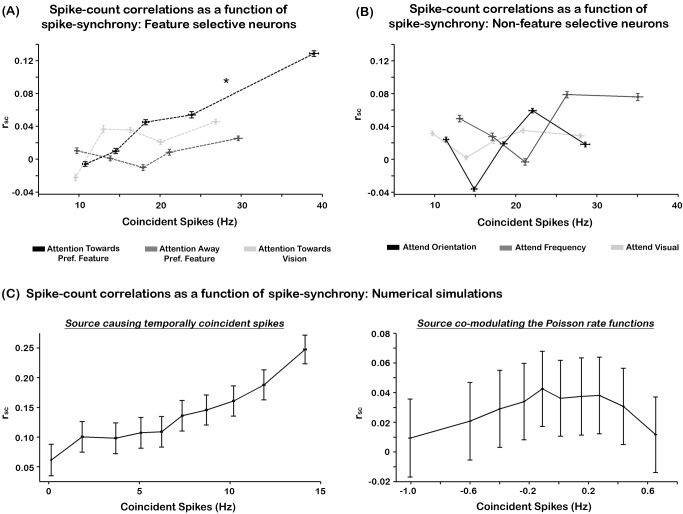
Relation between spike-synchrony and spike-count correlations.(A) rsc as a function of spike-synchrony in feature selective populations. The individual traces represent the binned rsc for the “attention towards preferred feature” (solid black trace), “attention away preferred feature” (dashed dark-gray trace), and “attention towards vision” (dashed light-gray trace). The results show that greater spike-synchrony led to enhanced rsc values only when attention was directed towards the preferred feature modality of the neural pairs (solid black trace). This is indicated by the asterisk (p<0.05). (B) rsc as a function of spike-synchrony in non-feature selective populations. Attention to orientation, frequency, and vision are represented in black, light gray, and dark gray, respectively. The horizontal and vertical error bars in Figure 6A and 6B represent the SEMwithin. (C) Numerical simulations of rsc as a function of spike-synchrony. The graphs show two scenarios that either caused temporally coincident spikes across two AP trains (left panel) or co-modulated the FRs of two spike trains (right panel). The simulations revealed a systematic relationship between rsc and spike-synchrony in the first scenario only. The error bars in all graphs represent 95% confidence intervals. The underlying data used to make this figure can be found in Data S1.